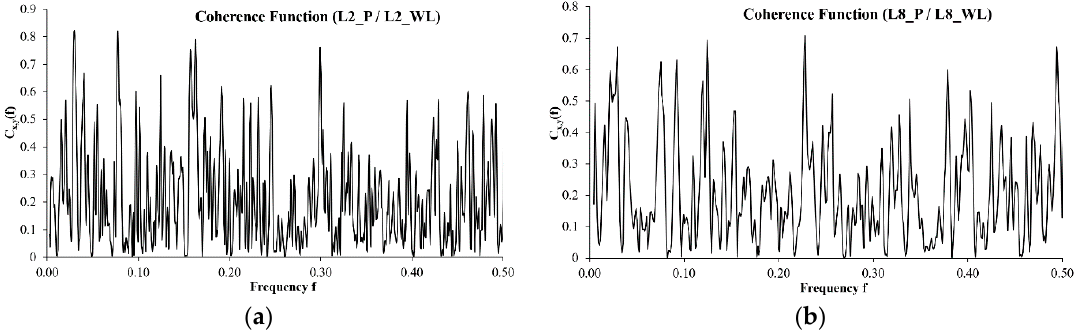
Figure 19. ( a ) Coherence function between the L2_P and L2_WL data; ( b ) coherence function between the L8_P and L8_WL data.